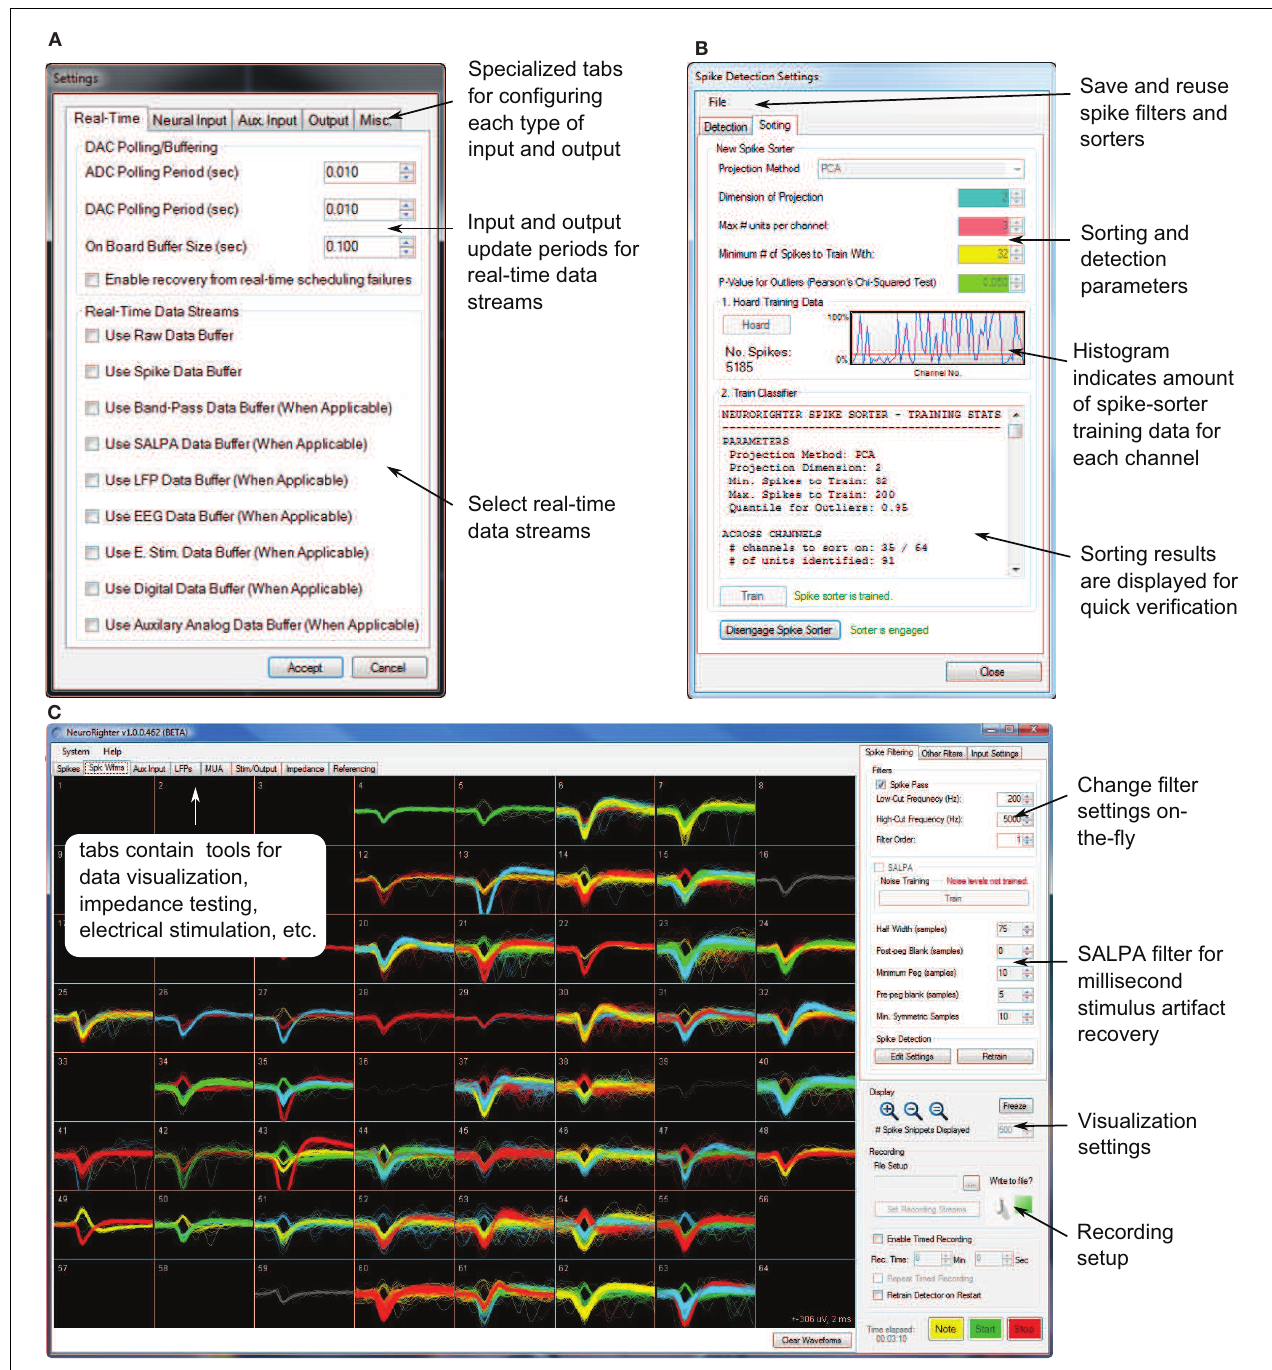
from a 59-channel, planar electrode array are shown on the spike visualization tab of the main GUI.The position of each waveform corresponds to